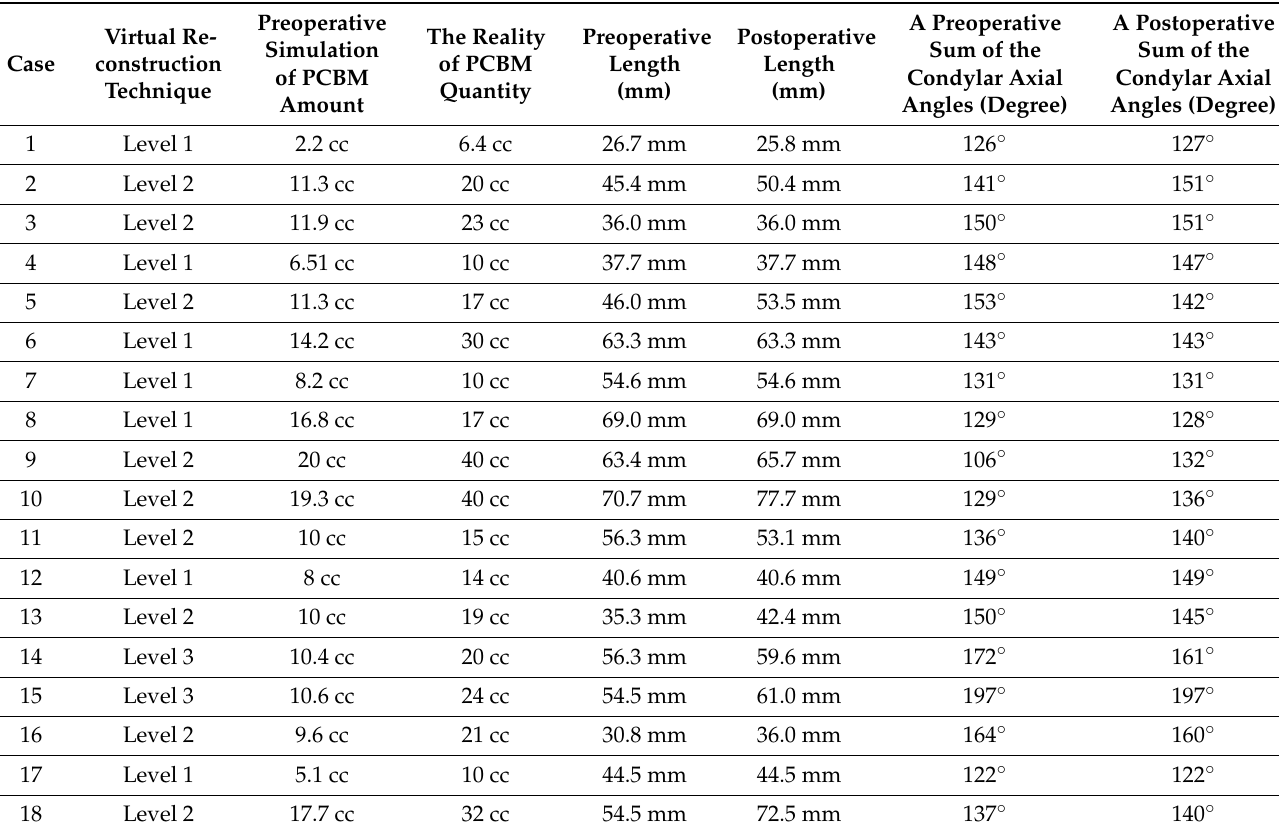
Table 2. The amount of PCBM simulation and realistic amount of PCBM, simulation techniques, difference of the mandibular length, and the condylar axial angle between pre- and